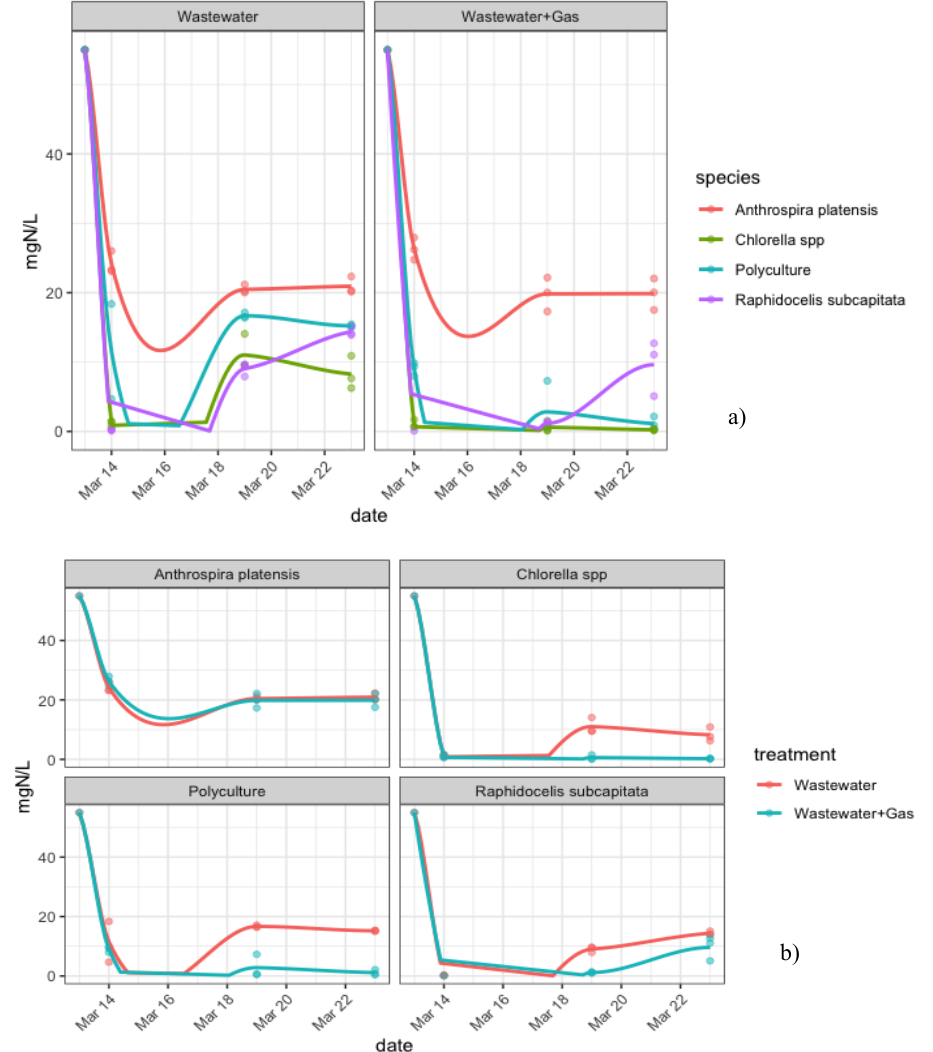
Fig. 2. Nitrogen consumption grouped by: a) treatment, b)